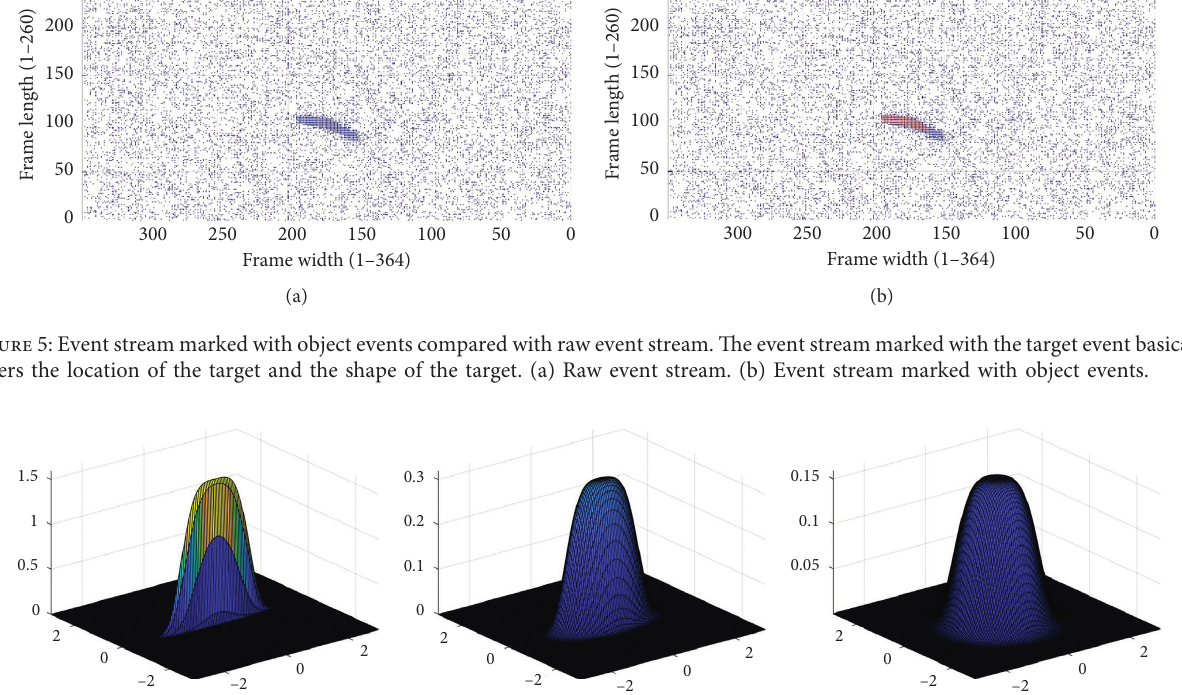
� 1; σ � 0.5. (c) σ 1 2